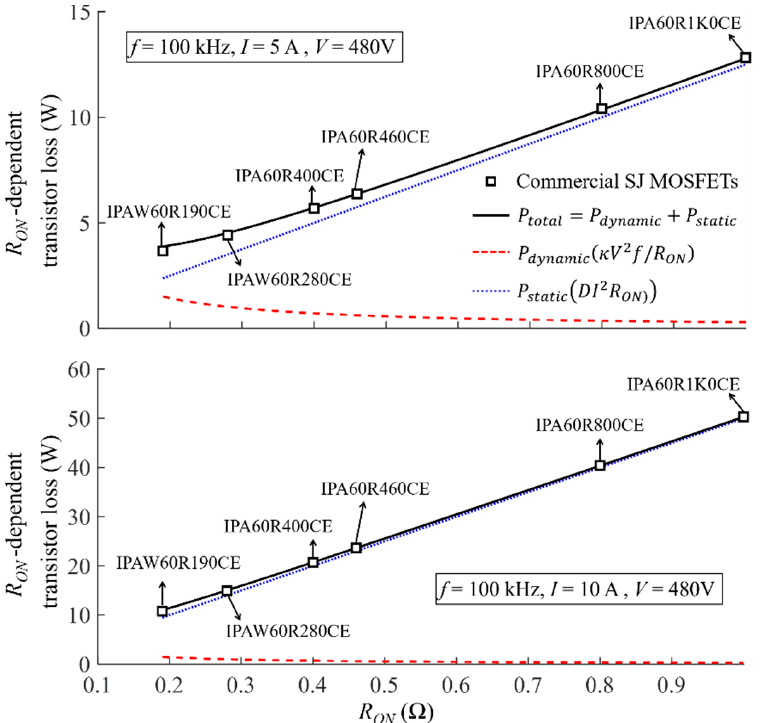
Figure 3. Comparison of the proposed theory at constant switching frequency of 100 kHz with the commercially available Infineon CoolMOS CE technology SJ MOSFETs.